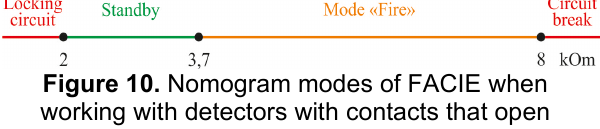
Figure 10. Nomogram modes of FACIE when working with detectors with contacts that open without verification for two FA